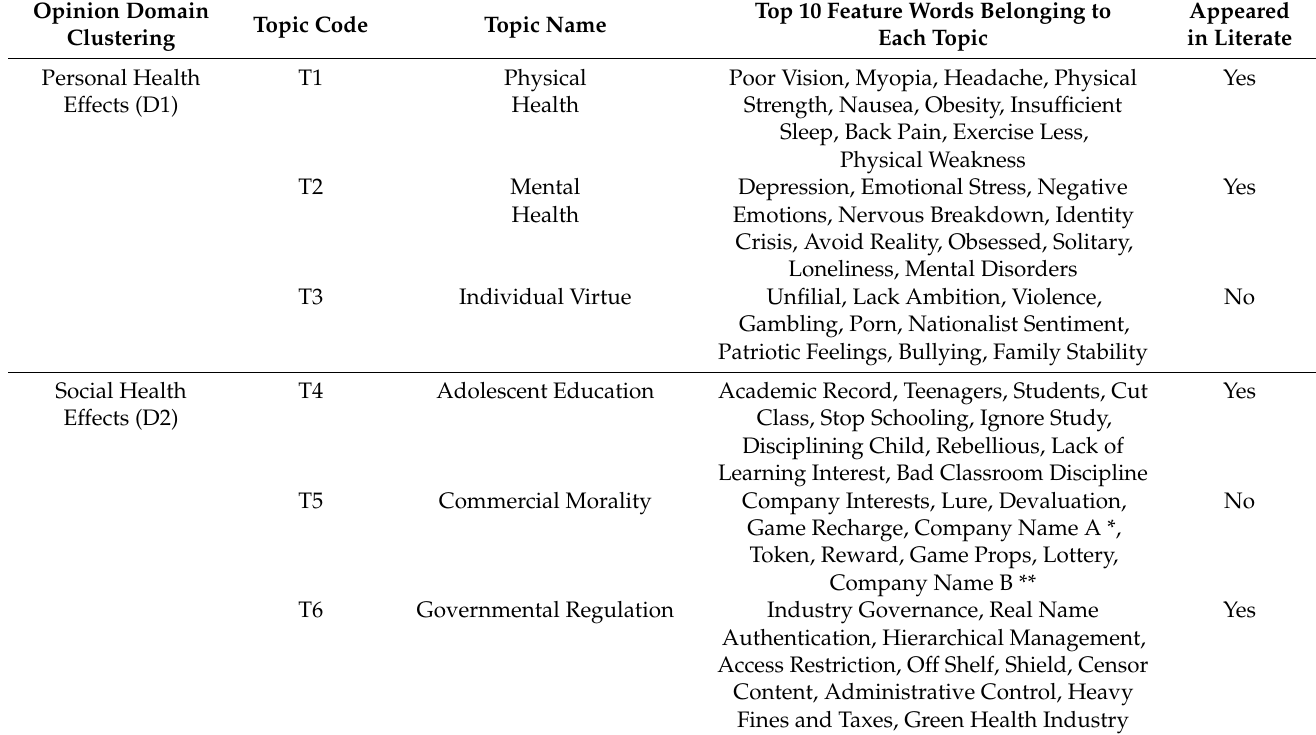
Table 2. Determined topics and domain